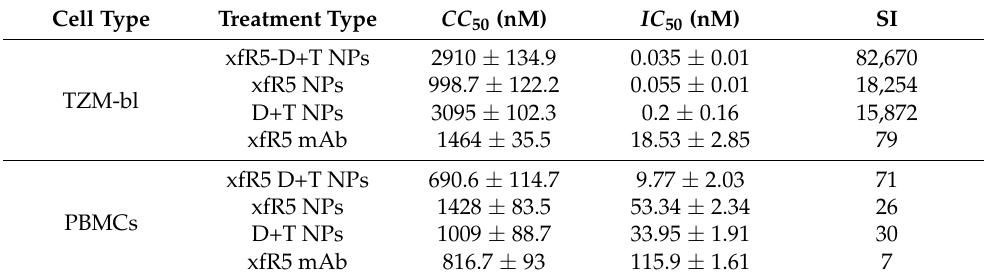
Table 5. Comparative cytotoxicity ( CC 50 ), HIV inhibition ( IC 50 ), and selectivity index (SI, CC 50 / IC 50 ) study of xfR5-D+T NPs vs. xfR5 mAb on TZM-bl cells and primary CD4+